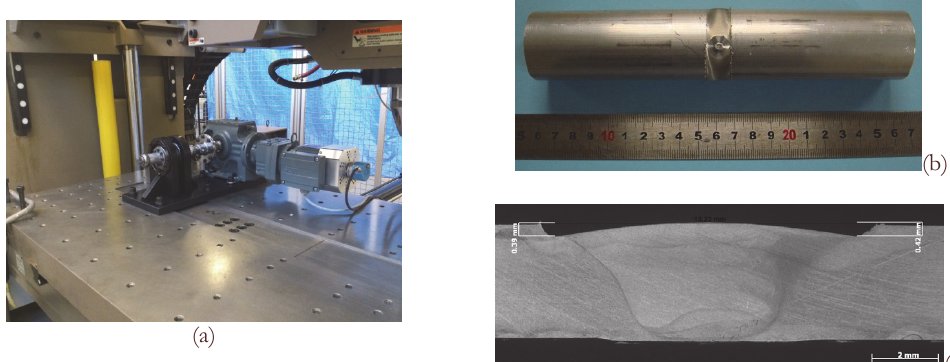
Figure 2: I-STIR FS welding platform equipped with a fourth axis (a); Al 6082-T6 FS welded tubular specimen (b); transverse macrosection of the weld region